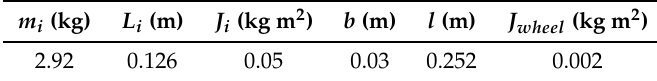
Table 5. The parameters of Qbot mobile robots.